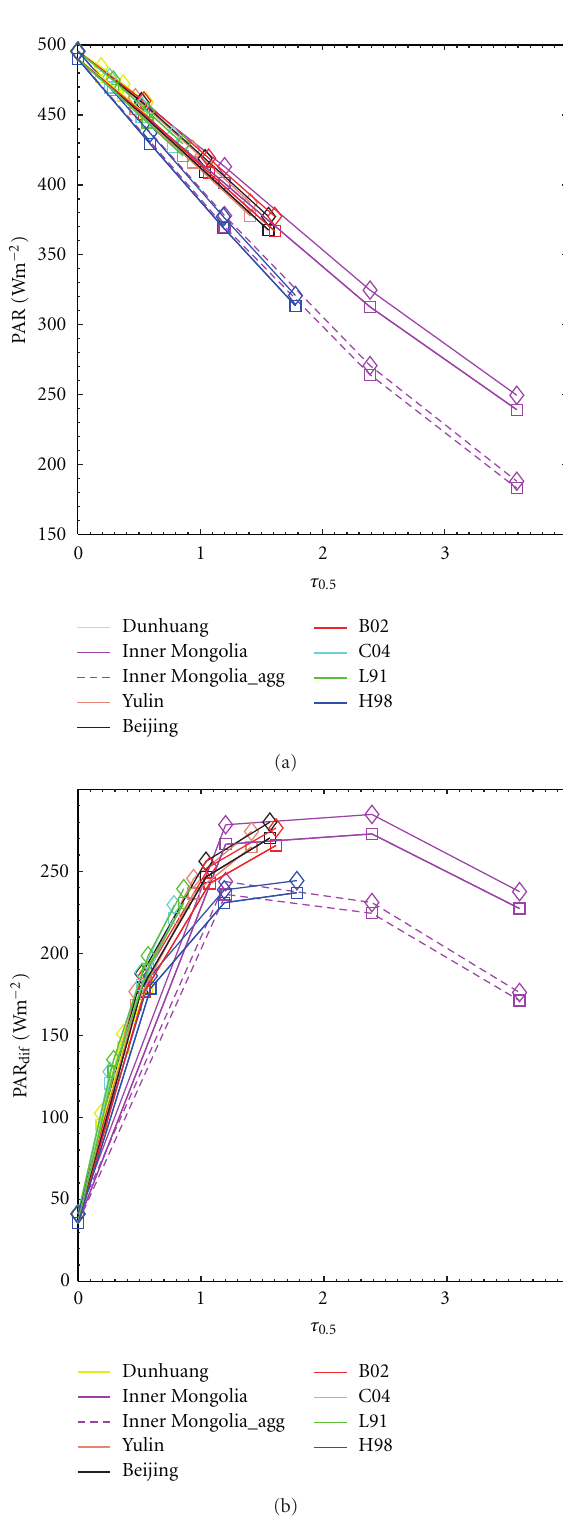
Figure 6: (a) Surface downwelling PAR as a function of dust optical depth ( τ 0 . 5 ); (b) same as (a) but for the di ff use PAR component (PAR dif ). Squares denote the use of cropland-2 surface albedo, and diamonds are for grassland. Sun elevation angle is 90 ◦ . Dust vertical profile is for mixed layer